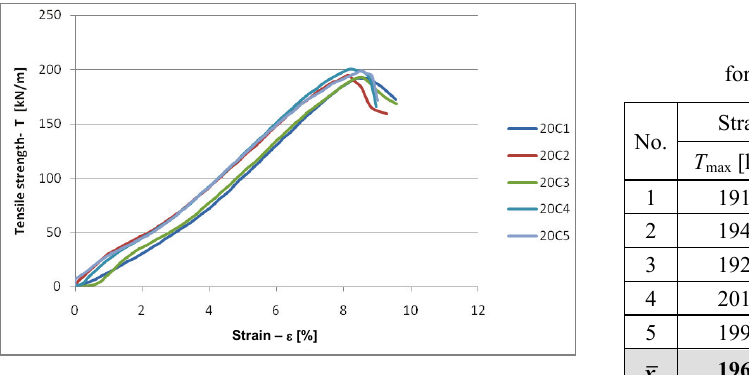
Fig. 2. Strain and load per unit width relationship for woven geotextile samples tested at 20 ° C and 20 mm/min strain rate